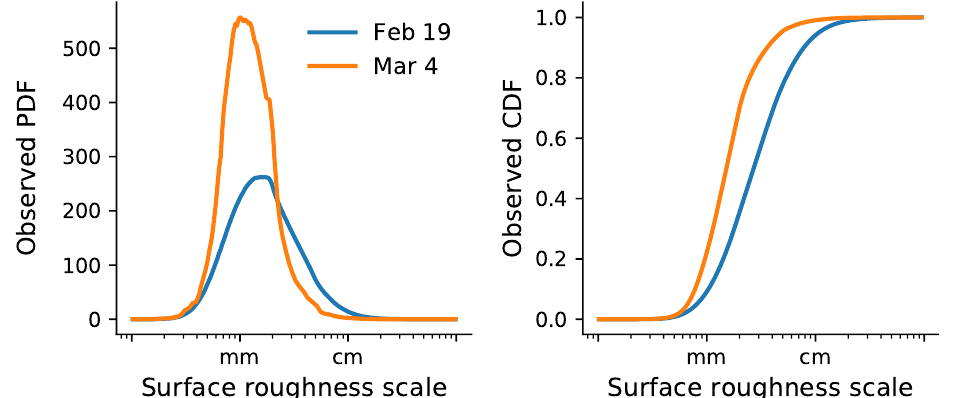
Figure 5. Observed probability density functions (PDF) and cumulative density functions (CDF) for UAV-derived river ice surface roughness measurements on 19 February and 4 March